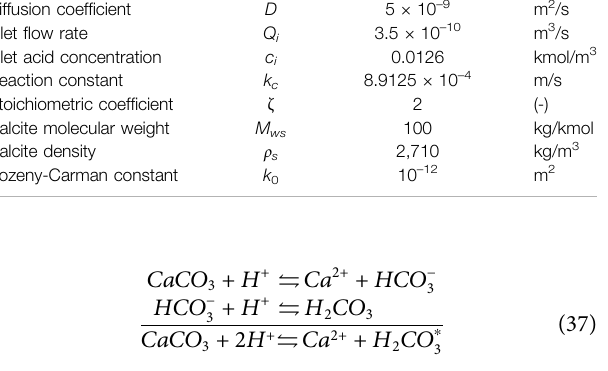
Frontiers in Earth Science |